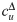
Parameter recovery with Ordered logistic regression and Beta-binomial distribution.Figure shows the estimate of group difference cuΔ on vertical axis that was obtained by fitting OLRM (left panel) and Beta-binomial distribution (right panel) to the data generated with OLRM by manipulating the magnitude of ceiling effect cu. cu is shown on the horizontal axis and the magnitude of the ceiling effect increases from left to right. In reference to the precise notation in section 2.3, the black line shows the median estimate of the group difference dcu, while the gray surface shows the estimate’s 95% interval. The blue line shows the true value used by OLRM that generated the data and the true value corresponds to an OLRM estimate of group difference in [1] (i.e. median estimate of d0). The crosses show the difficulty of the six items (i.e. bis) in the original study (green [1]) and in the replication study (red [2]), while ci and grid lines of the horizontal axis show the OLRM thresholds obtained by pooling the original and replication data.